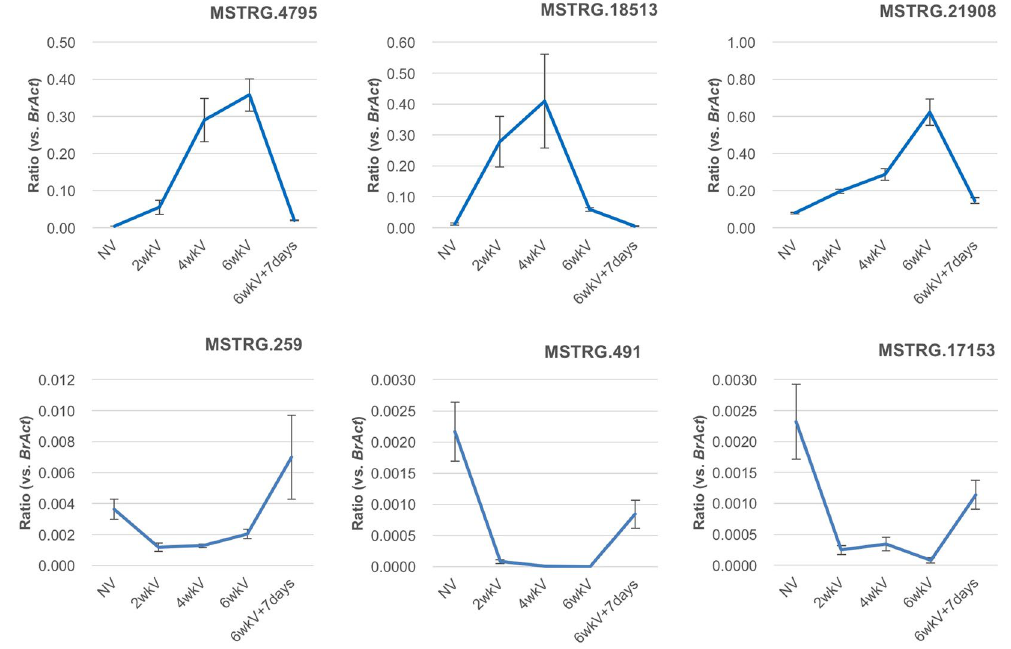
Figure 3. LncRNA expression levels after cold treatment measured by qPCR. Values are means ± s.e. (three biological and technical replicates) of relative expression levels compared with Bractin . NV, without cold treatment; 2wkV, after two weeks of cold treatment; 4wkV, four weeks of cold treatment; 6wkV, six weeks of cold treatment; 6wkV + 7 days, seven days after a return to normal growth conditions after six weeks of cold